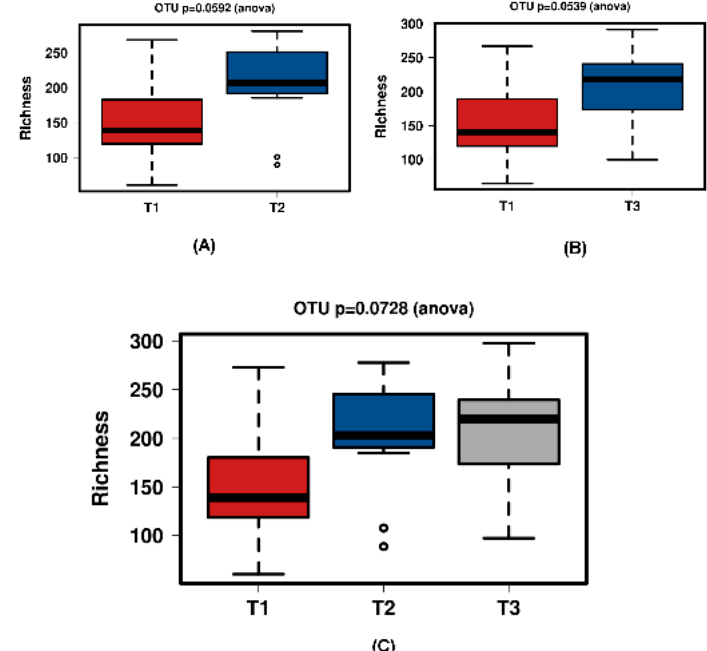
Figure 8. Richness for the JooMo group samples. ( A ) shows T1 and T2 with a significant increase over time. Samples normalised to a read depth of 2364 sequences; ( B ) shows T1 and T3 with a significant increase over time. Samples normalised to a read depth of 2366 sequences; ( C ) shows T1, T2 and T3 with a non-significant increase over time. Samples normalised to a read depth of 2361 sequences.